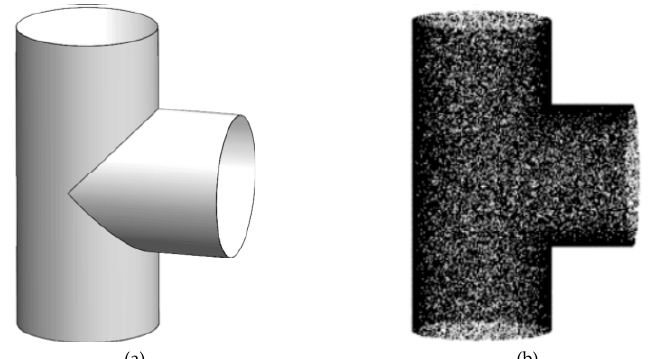
Figure 1. The full point-pair feature with curvature pipeline. The proposed method can be divided into offline stage and online stage.